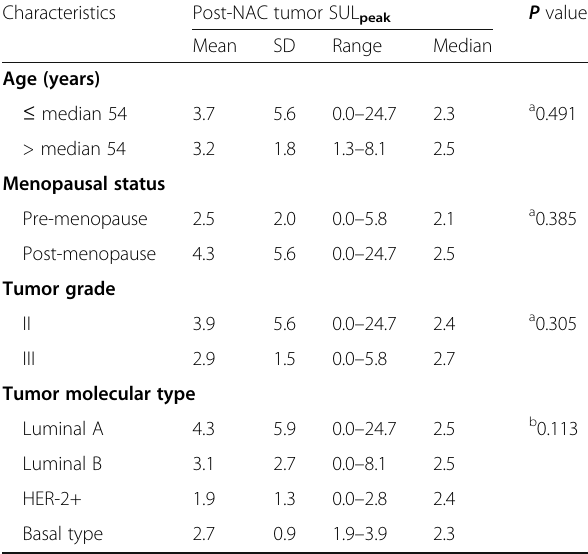
Table 7 Relationship between demographic / histopathologic features and post-NAC tumor SUL peak